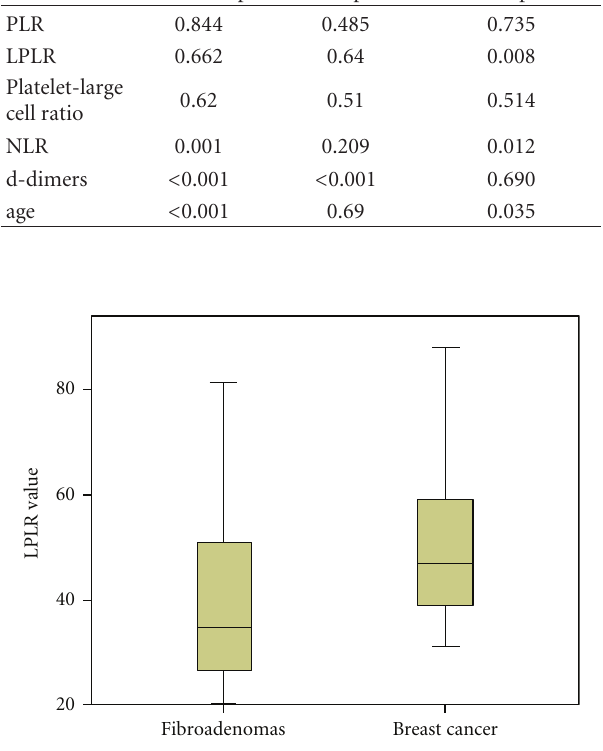
Figure 4: LPLR values in groups A versus B and C (fibroadenomas versus breast